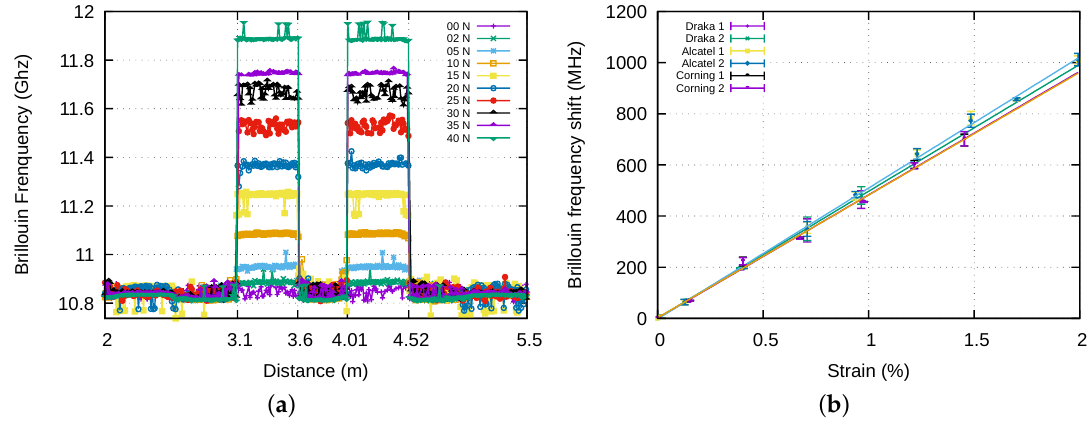
Figure 11. ( a ) Brillouin frequency profile for Alcatel fibres. ( b ) Variation of the Brillouin frequency with